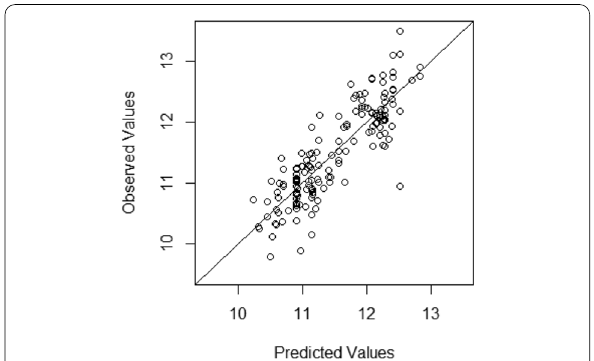
Fig. 4 Scatter plot of predicted and observed values of Analysis 1 (Martin). The unit of the axes is the logarithm of winning bid price